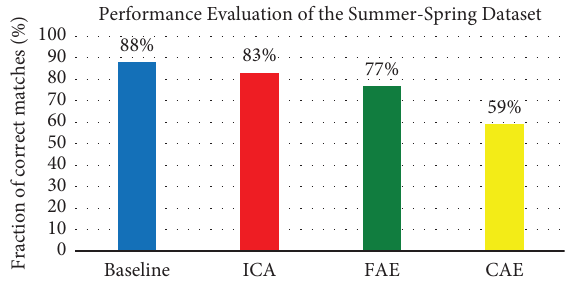
Figure 16: Fraction of correct matches of the baseline and pro- posed algorithms on the summer-spring dataset.